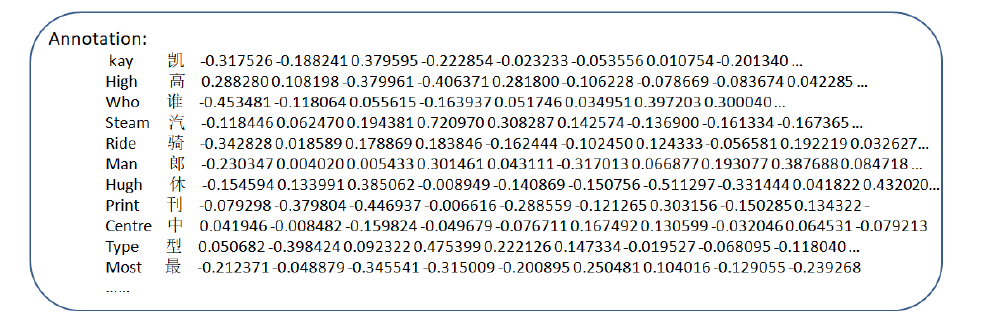
Figure 3. The architecture of BGRU (bidirectional gated recurrent unit)+Attention used for the sentence encoder.